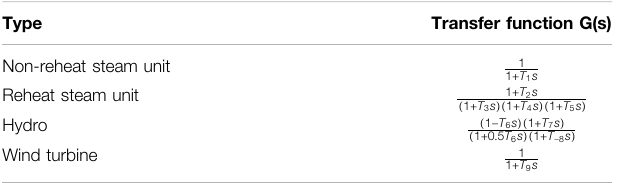
TABLE 1 | Types of transfer functions for various units.